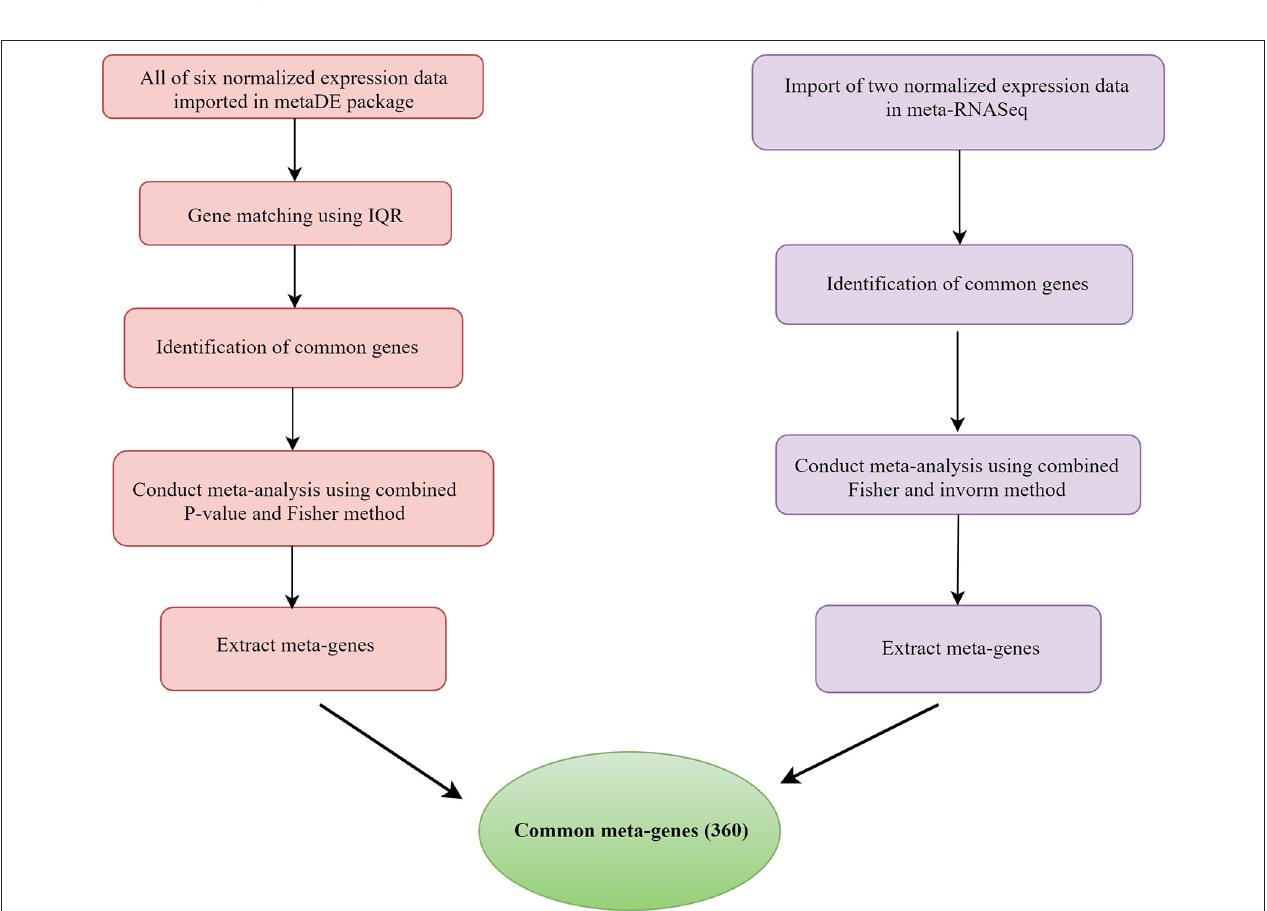
FIGURE 1 | Flowchart of different steps of mastitis microarray and RNA-seq meta-analysis based on combing p value.